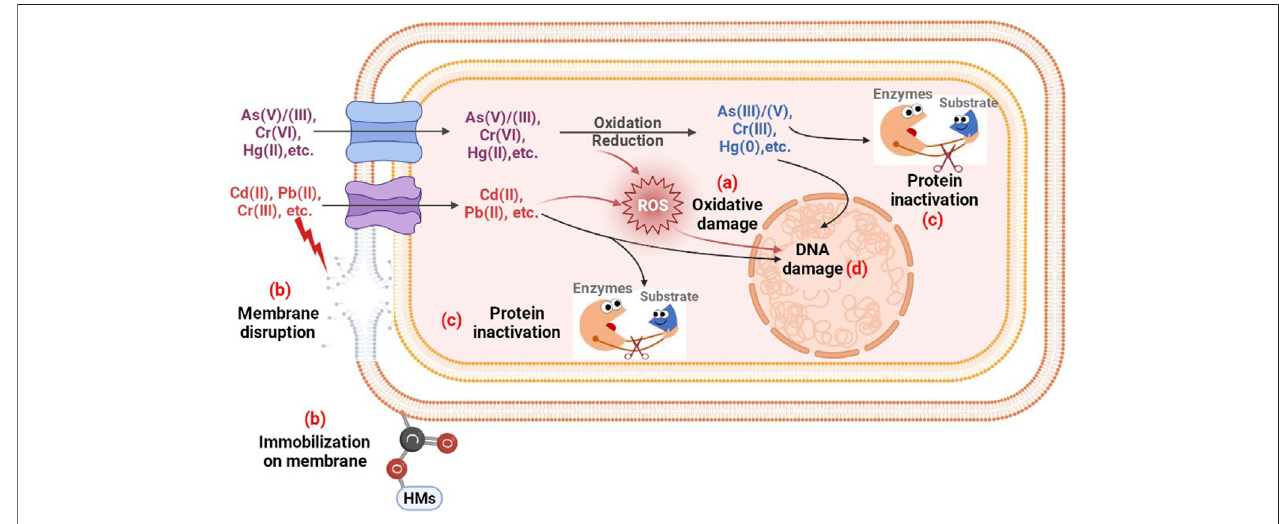
FIGURE 2 | The possible toxic mechanism of HMs to prokaryotes. (A) Oxidative damage resulting from excessive ROS; (B) Structural disruption and metal ion immobilization on membranes; (C) Protein regulation; (D) DNA damage caused by oxidative stress and metal ions.